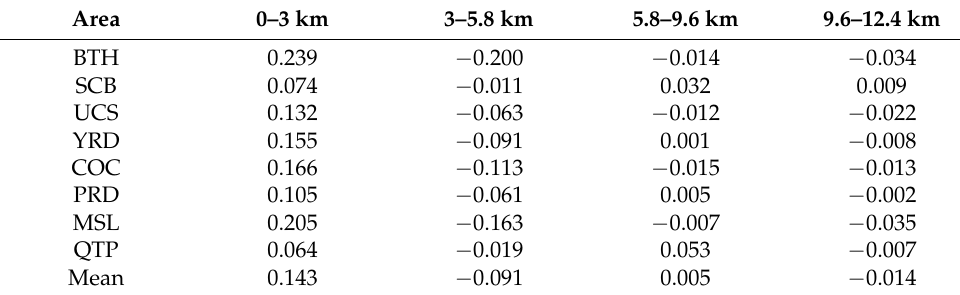
Figure 6. Interannual variation characteristics of OCC at different altitudes in each study area: ( a ) interannual variation characteristics of OCC at 0–3 km; ( b ) interannual variation characteristics of OCC at 3–5.8 km; ( c ) interannual variation characteristics of OCC at 5.8–9.6 km; ( d ) interannual variation characteristics of OCC at 9.6–12.8 km. Table 3. MYC of OCCs at different tropospheric altitudes (DU).